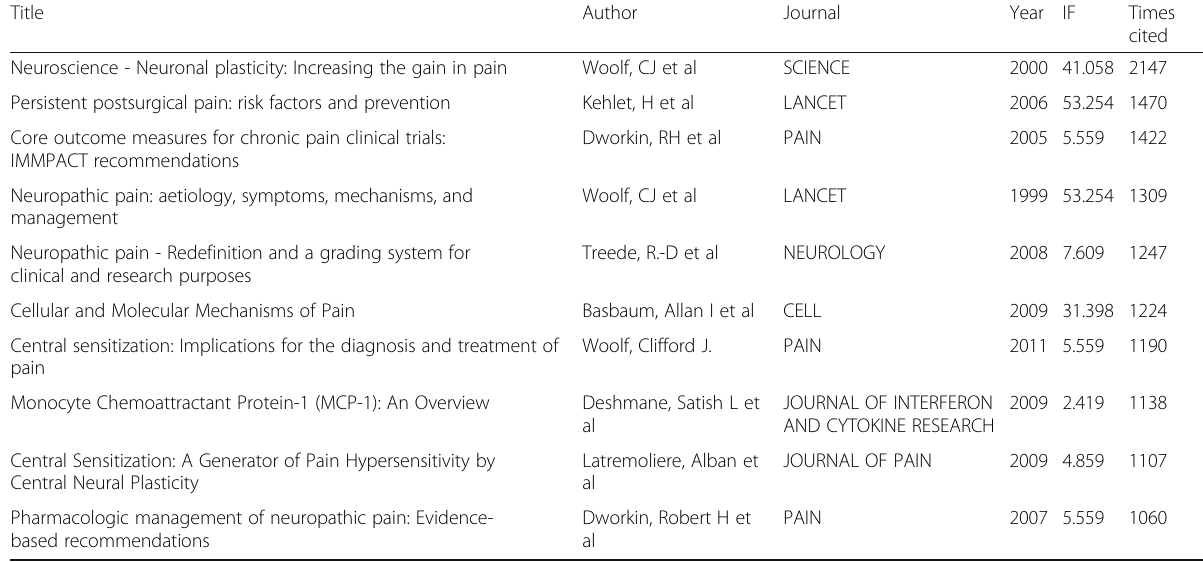
Table 1 The Top 10 most frequently cited articles on neuropathic pain in the world